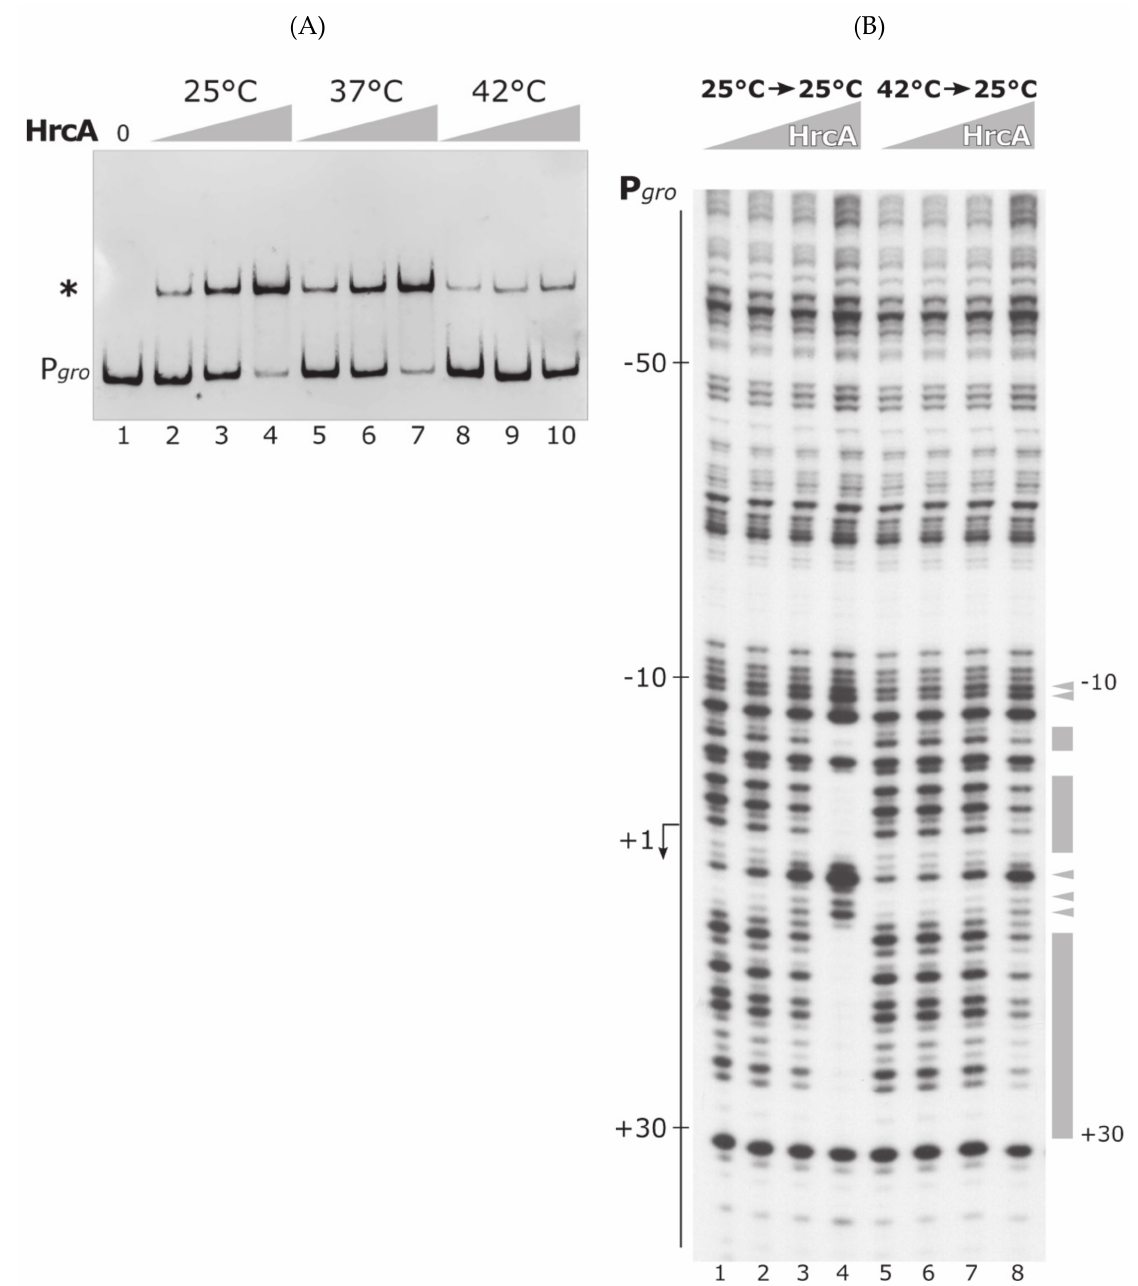
Figure 5. DNA-binding experiments of HrcA exposed to different temperatures and recovered at 25 ◦ C. ( A ) EMSA carried out with purified HrcA on P gro promoter probe. DNA–protein complexes were allowed to form for 10 min at 25 ◦ C, then reactions were moved to different temperatures (25, 37 or 42 ◦ C) for 10 min. Following heat-challenge, reactions were incubated at 25 ◦ C for a 10-min recovery step [26]. On the left, an asterisk marks the HrcA shifted band, while the label “P gro ” indicates the free probe. Lanes 1–4 contain 0, 45, 90 and 180 nM HrcA, respectively. Lanes 4–6 and 8–10 contain the same increasing concentrations of HrcA as in samples 2–4. Grey triangles indicate increasing amounts of HspR at the indicated temperatures; 0, no protein added. ( B ) DNase I footprinting assays with HrcA on P gro labeled probe. Protein–DNA mixes were incubated for 10 min at 25 ◦ C, then moved to 25 or 42 ◦ C for 10 min, followed by a recovery step at permissive (25 ◦ C) temperature, before DNase I cleavage. Lanes 1–4 and 5–8 contain 0, 45, 90 and 180 nM HrcA, respectively. On the left of the autoradiograph, the numbers refer to the positions with respect to the transcriptional start site (indicated by a bent arrow). Protected regions and DNase I hypersensitive sites are indicated on the right by grey boxes and arrowheads, respectively, together with positions delimiting the HrcA binding site. Grey triangles are as in panel a. Symbol * indicates the HrcA shifted